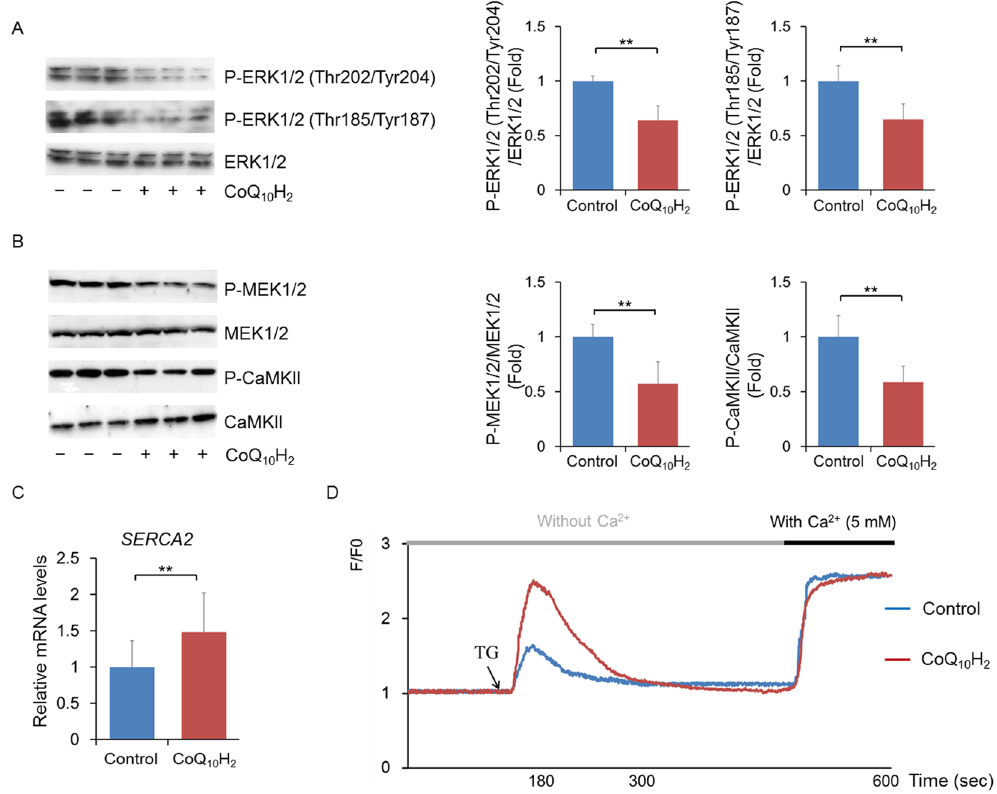
Figure 5. CoQ 10 H 2 inhibited the activity of CaMKII and MEK1/2 and therefore inhibited phosphorylation of ERK1/2 by enhancing the expression and function of SERCA2. ( A ) Phosphorylated ERK1/2 and total ERK1/2 in HepG2 cells were measured by Western blotting 24 hours after CoQ 10 H 2 (5 μ M) supplementation. All blots were obtained under the same experimental conditions, and cropped images of the blots are shown. Densitometric quantification is depicted in the right panel. (n = 9, ∗∗ p < 0.01; mean ± SD, Student’s t-test); ( B ) Phosphorylation levels of CaMKII and MEK1/2, the upstream regulators of ERK1/2, were detected by Western blotting in HepG2 cells 24 hours after supplementation with CoQ 10 H 2 (5 μ M). All blots were obtained under the same experimental conditions, and cropped images of the blots are shown. Densitometric quantification is depicted in the right panel. (n = 9, ∗∗ p < 0.01; mean ± SD, Student’s t-test); ( C ) Gene expression of SERCA2 in HepG2 cells was determined by real-time PCR 24 hours after CoQ 10 H 2 (5 μ M) supplementation. (n = 9, ∗∗ p < 0.01; mean ± SD, Student’s t-test); ( D ) Determination of intracellular calcium concentration by Flou-3AM (40 μ M). HepG2 cells were supplemented with CoQ 10 H 2 (5 μ M) for 24 hours, and then the SERCA2 inhibitor Thapsigargin (Tg) (200 nM) and Ca 2 + (5 mM free extracellular Ca 2 + final concentration) were added to the cells, and changes in fluorescence were observed (see the Supplementary Data for